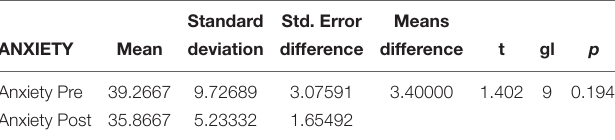
TABLE 11 | Student Engagement (SEM), pre- and post. TABLE 13 | Perceived anxiety (STAI S) by students, pre- and post.